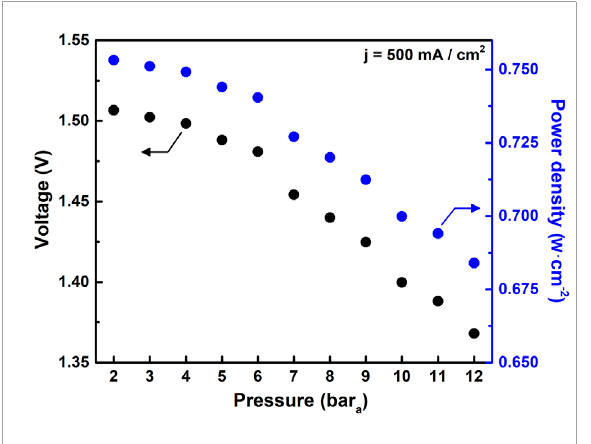
FIGURE 6 Impact of pressure on electrolysis driving voltage and power at a current density of 500 mA cm −2 .